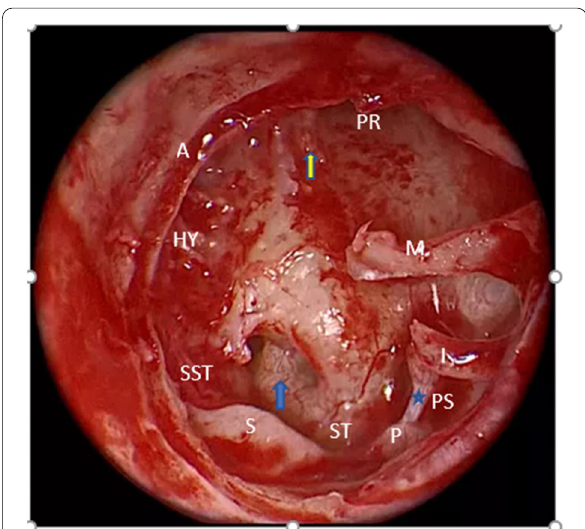
Fig. 3 The middle ear cavity by 0° endoscope: m. malleus, I incus, star: stapedius tendon attached to stapes head, P pyramidal eminence with the ponticulus originating from it, S: styloid eminence, the blue arrow refers to oblique fustis with subcochlear canaliculus below, ST sinus tympani, and SST sinus subtympanicus. The yellow arrow: the protinaculum. AG annular groove, HY hypotympanum, and PR protympanum. We can consider 2 spaces lateral to P, S (facial recess and lateral sinus) and 3 spaces medial (posterior sinus, sinus tympani, and sinus